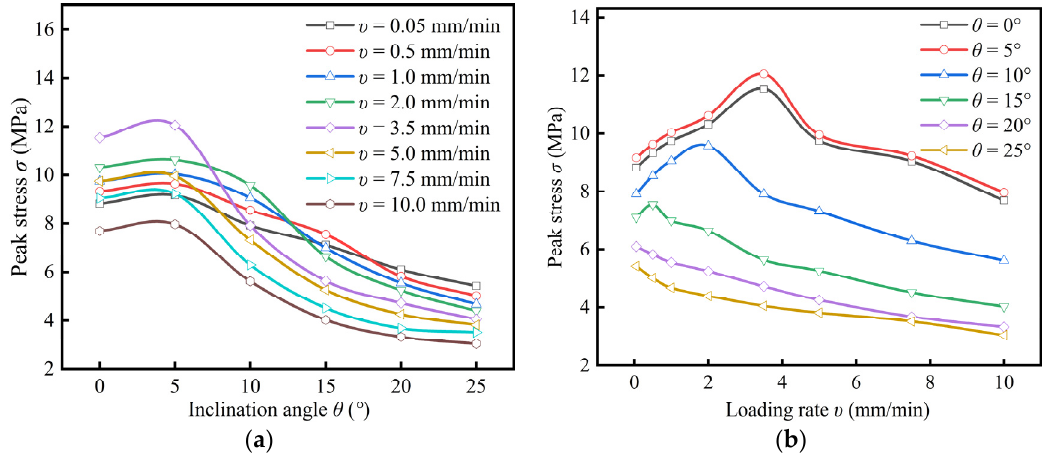
Figure 9. Variation law of peak axial stress of coal sample with loading rate and inclination angle: ( a ) Relationship between peak axial stress and inclination angle; ( b ) relationship between peak axial stress and loading rate. Table 2. Peak axial stress varies with the loading rate and inclination angle.